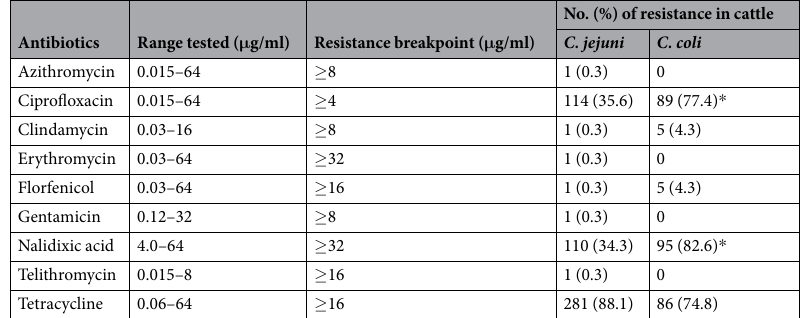
Table 2. Prevalence of antimicrobial resistance in Campylobacter jejuni (n = 320) and C. coli (n = 115) from feedlot cattle. * Significantly different resistance ( P < 0.05) compared with C. jejuni